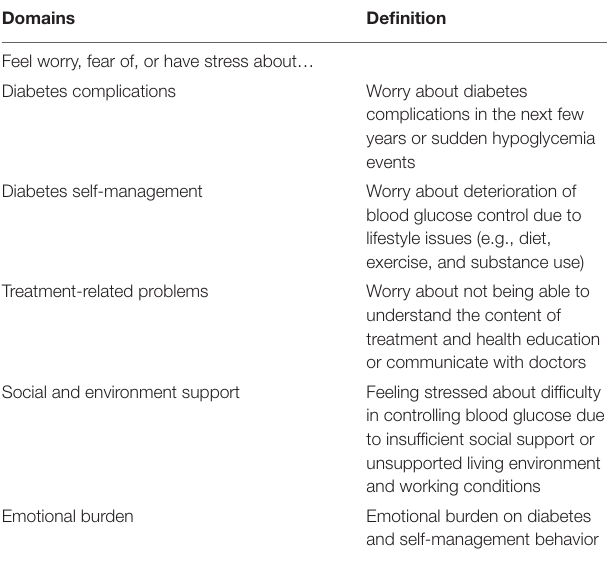
TABLE 1 | Definitions of the Taiwanese diabetes distress